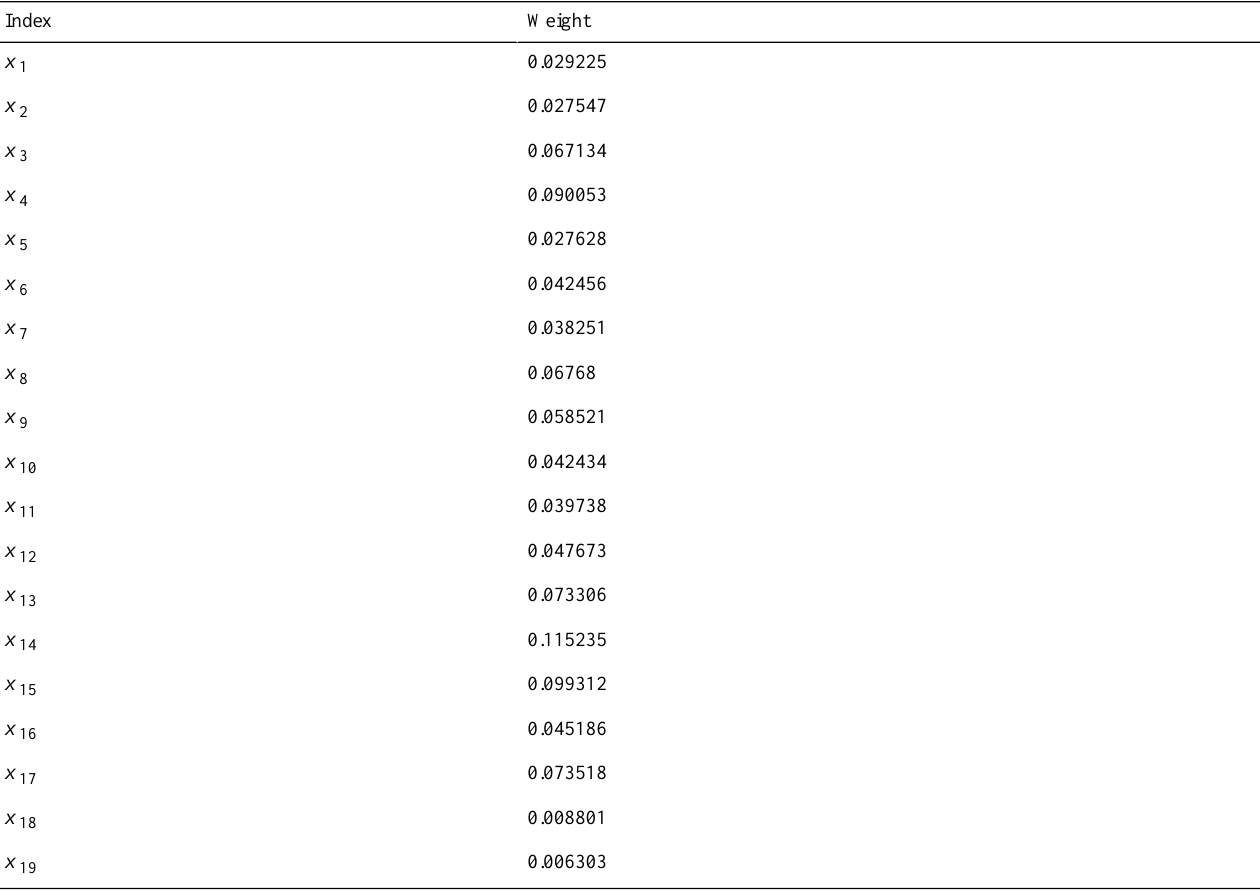
Table 9. The index weight of WeChat official accounts for assisted reproduction technology